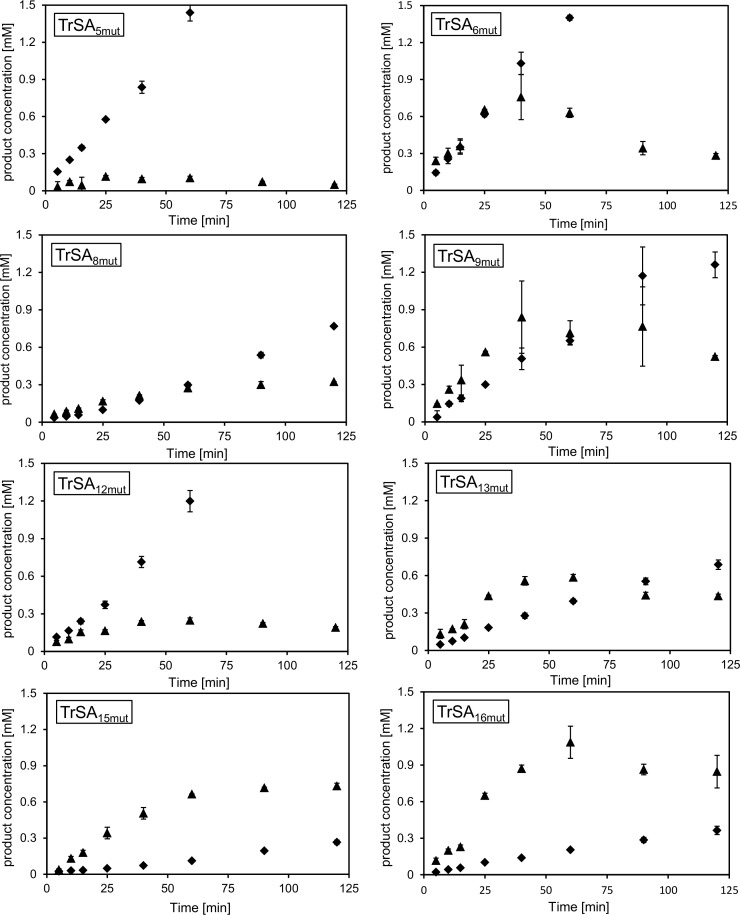
Time course experiments for 3’SL production.Time course experiments using the different TrSA mutants: TrSA5mut, TrSA6mut, TrSA8mut, TrSA9mut, TrSA12mut, TrSA13mut, TrSA15mut, and TrSA16mut. The concentration of SA (diamonds) and 3’SL (triangles) at the respective sampling times is shown. Mutants with the structural mutation (TrSA6mut, TrSA9mut, TrSA13mut, and TrSA16mut) were assayed using 15 μg/mL enzyme and those without (TrSA5mut, TrSA8mut, TrSA12mut, and TrSA15mut) were assayed using 1.5 μg/mL. TrSA5mut, TrSA6mut and TrSA12mut had a very fast initial hydrolysis (SA), whereas reasonable amounts of 3’SL were generated by the remaining enzymes. TrSA15mut and TrSA16mut, however exhibited the highest ratio of 3’SL:SA.